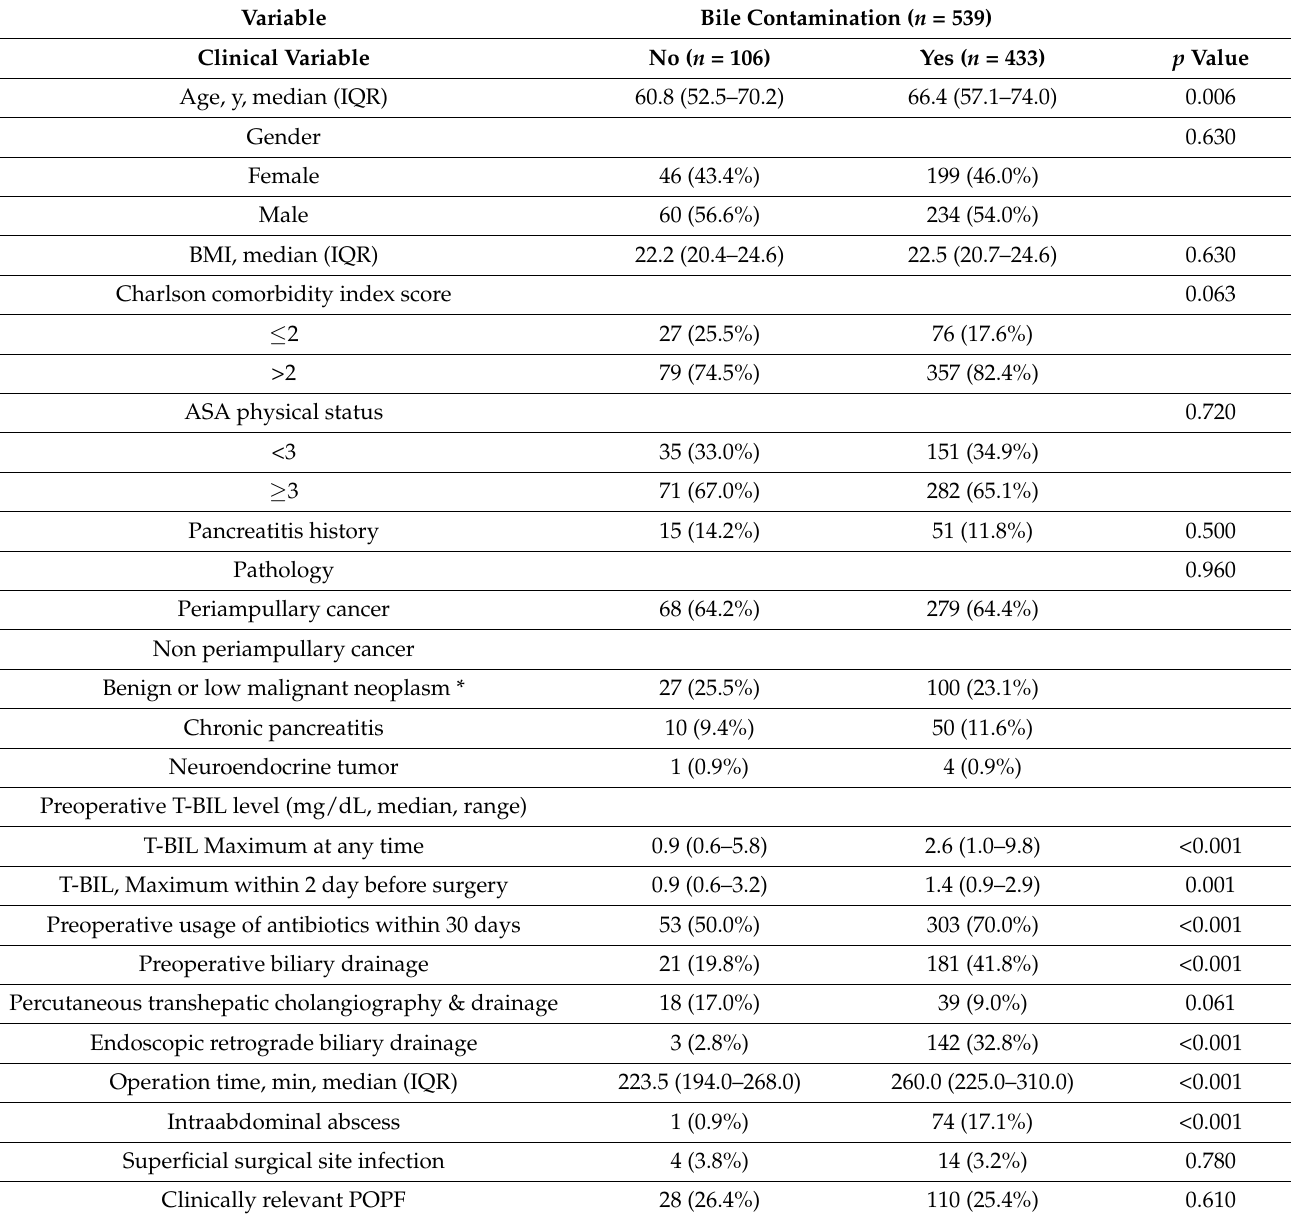
Table 1. Comparison of the study subjects between with and without bile